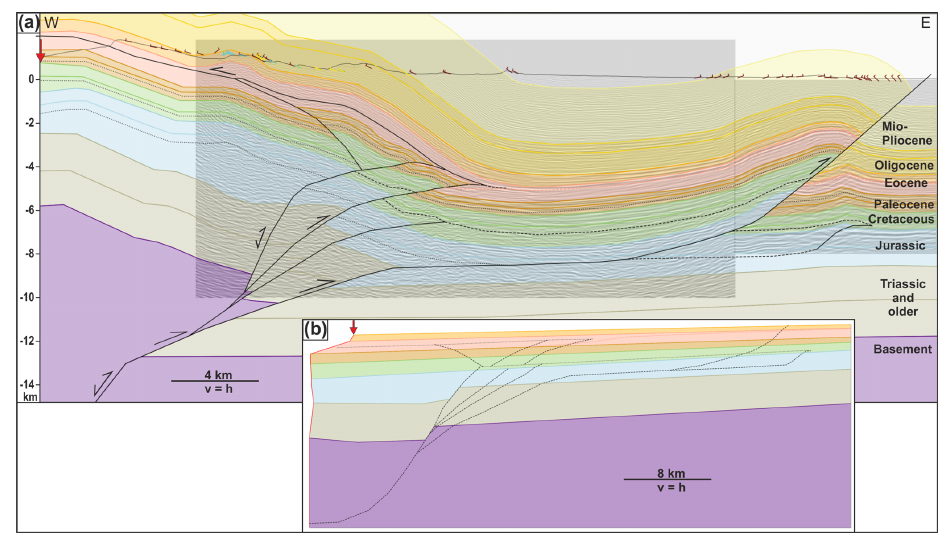
Figure 12. (a) Constructed W–E section in the southern sector of the study area with a PSDM seismic section in the background (see Fig. 9b). The section is balanced between the red loose line and the eastern end of the section (fixed line). KE: Kirthar Escarpment; (b) restored section (50% scale of a ). Calculated shortening is approximately 10km or 20%.